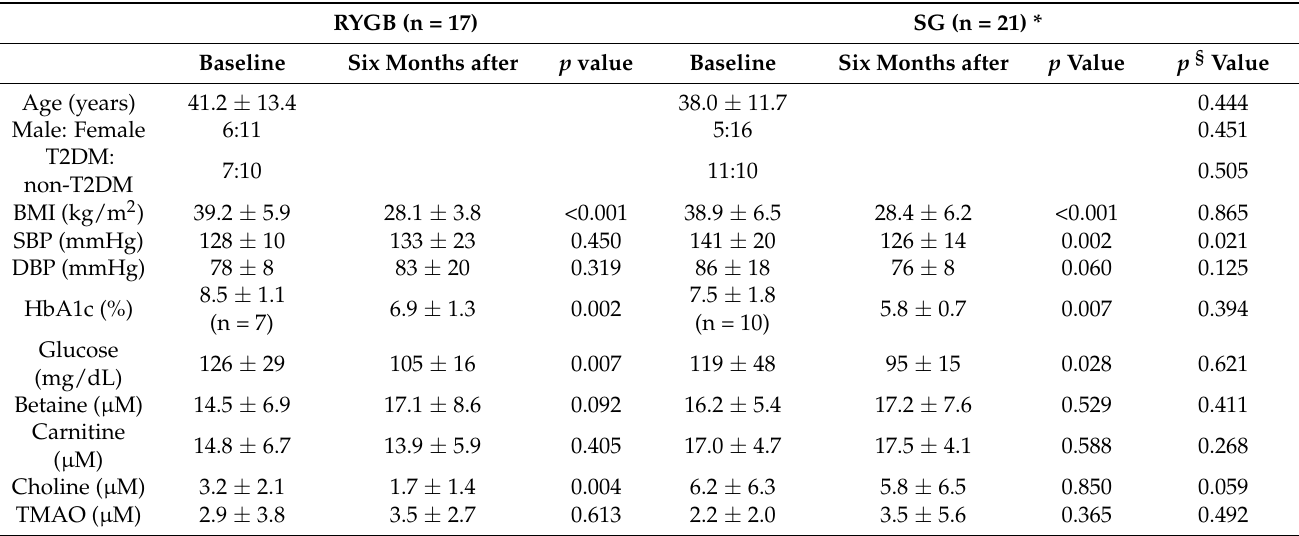
Figure 1. Serum levels of metabolites at baseline (black bars) and six months after bariatric surgery (gray bars) in ( A ) Type 2 diabetes mellitus (T2DM) and ( B ) non-T2DM patients. Abbreviation: T2DM, type 2 diabetes mellitus; TMAO. Trimethylamine-N-oxide. Table 4. Serum indices at baseline and after six months in subjects who underwent Roux-en-Y gastric bypass (RYGB) and sleeve gastrectomy